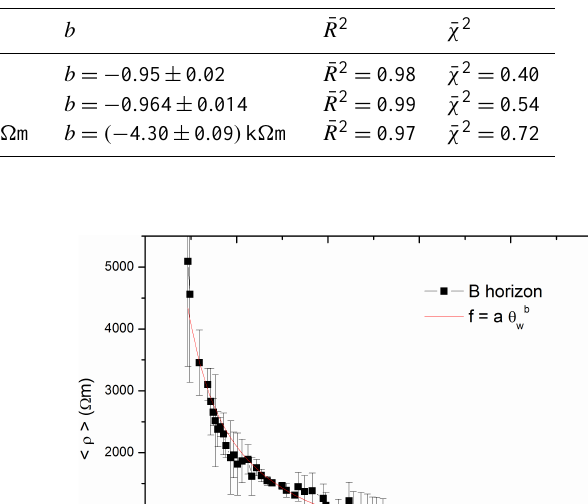
Table 1. Fit of model parameters to laboratory resistivity data.